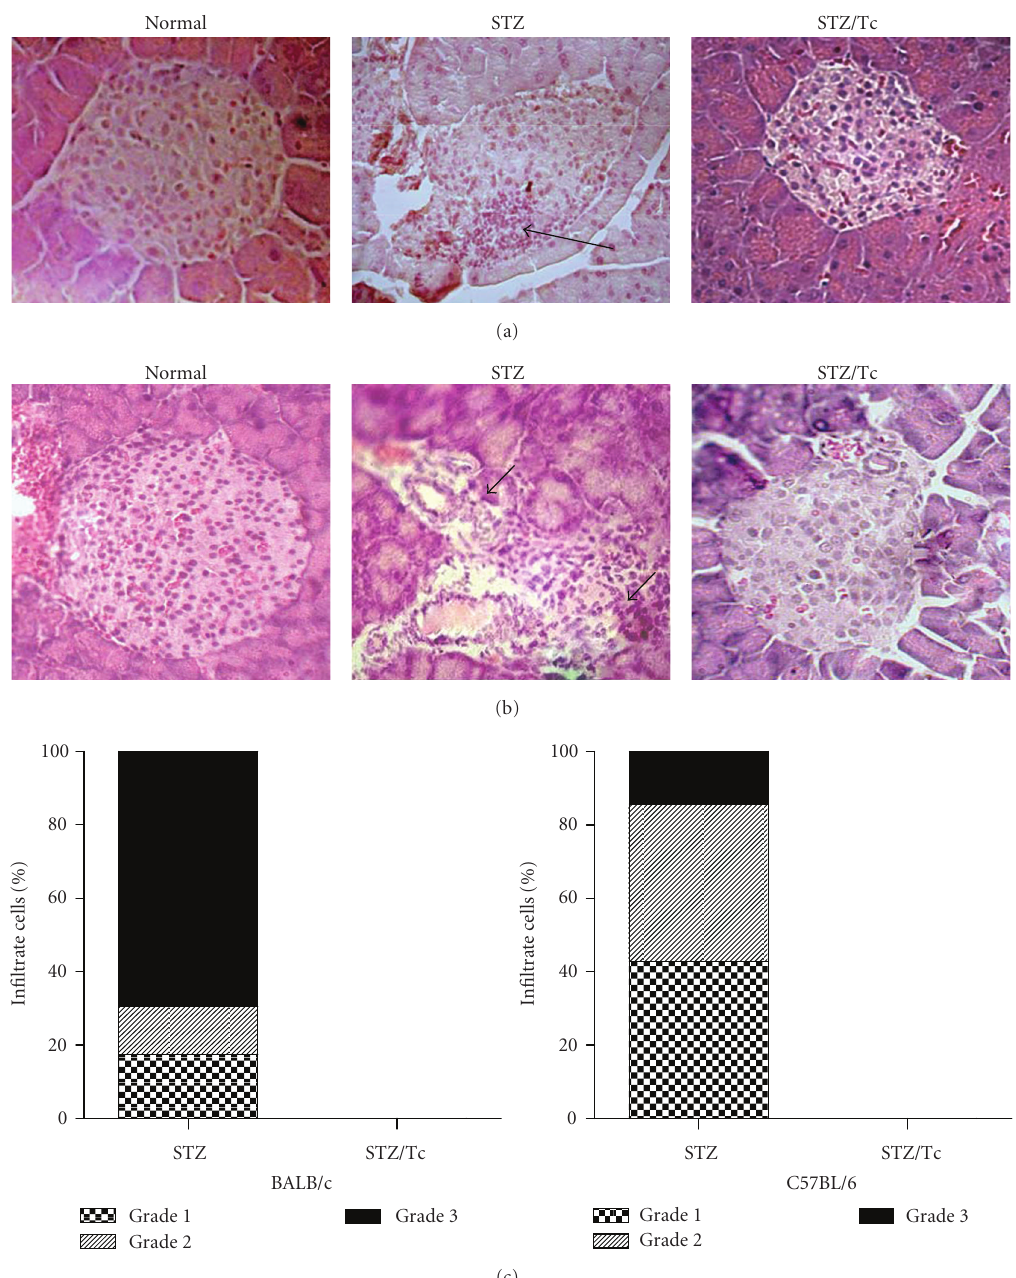
Figure 3: MLDS-mediated insulitis in BALB/c mice. All mice received MLDS for 5 consecutive days and were sacrificed 6 weeks later to harvest tissues for histopathology. (a) H&E stained BALB/c mouse pancreas sections: normal islet, STZ (uninfected and MLDS-treated), STZ/Tc ( T. crassiceps -infected and MLDS-treated). (b) H&E stained C57BL/6 mouse pancreas sections. (c) Score of cell infiltrates in BALB/c and C57BL/6 islets. Note the lack of leukocyte infiltrates in T. crassiceps -infected mice. Arrows indicate infiltration. Magnification ×